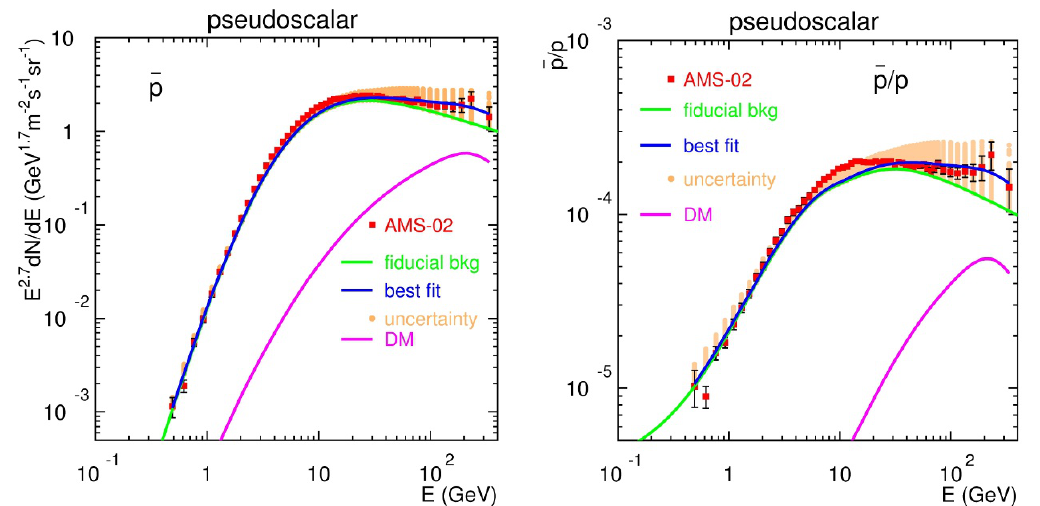
Figure 3 . Antiproton (cid:13)ux (left) and antiproton-to-proton ratio (right) observed by AMS-02 (red dots and dark error bars) in the simpli(cid:12)ed dark matter model with a pseudoscalar mediator. The blue solid line shows the prediction of the total cosmic ray (cid:13)ux with dark matter parameter values that best (cid:12)t the AMS-02 data. The total predicted (cid:13)ux is the sum of the background (cid:13)ux (green curve) and the dark matter contribution (purple curve). Salmon dots indicate the 2 (cid:27) con(cid:12)dence region of the